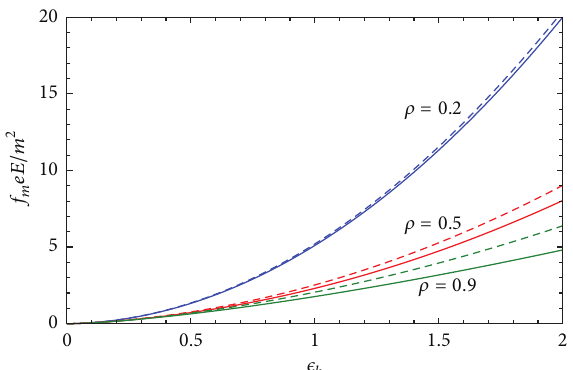
Figure 12: Dimensionless function 𝑓 𝑚 𝑒𝐸/𝑚 2 versus 𝜖 𝑏 for different values of 𝜌 . The solid line is the full relativistic calculation, the dashed line is the nonrelativistic approximation. 𝐽/𝜓 binding energy in vacuum corresponds to 𝜖 𝑏 = 0.68